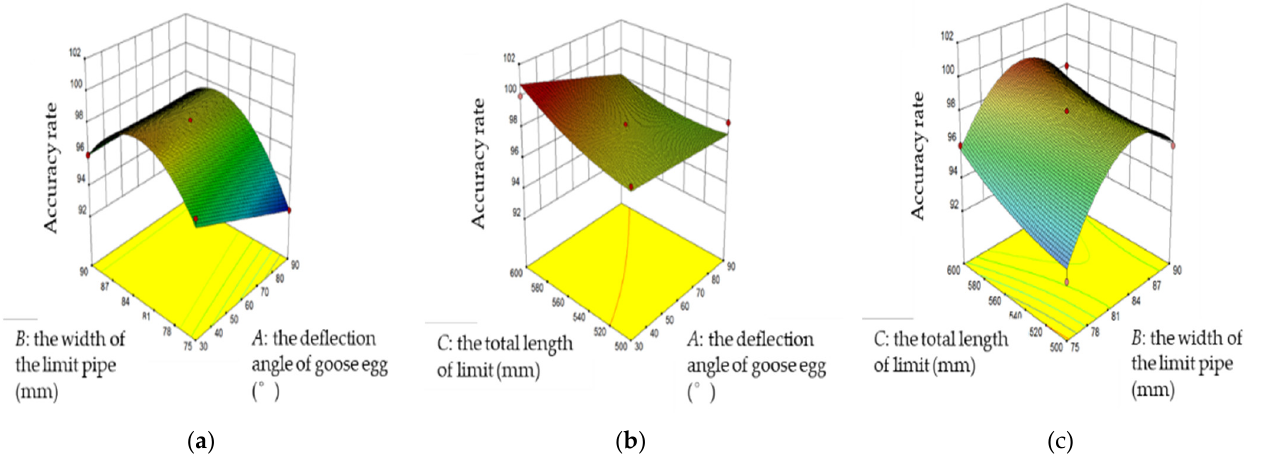
Figure 7. The 3D response surface diagram of interaction effects of various factors: ( a ) relationship among accuracy, width of the limit pipe, and deflection angle of goose egg; ( b ) relationship among accuracy, total length of the limit device, and deflection angle of goose egg; ( c ) relationship among accuracy, total length of the limit device, and width of the limit pipe.